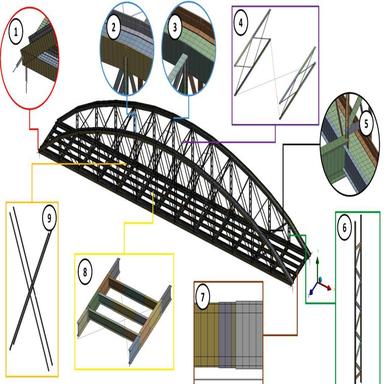
FE model of O Barqueiro bridge.